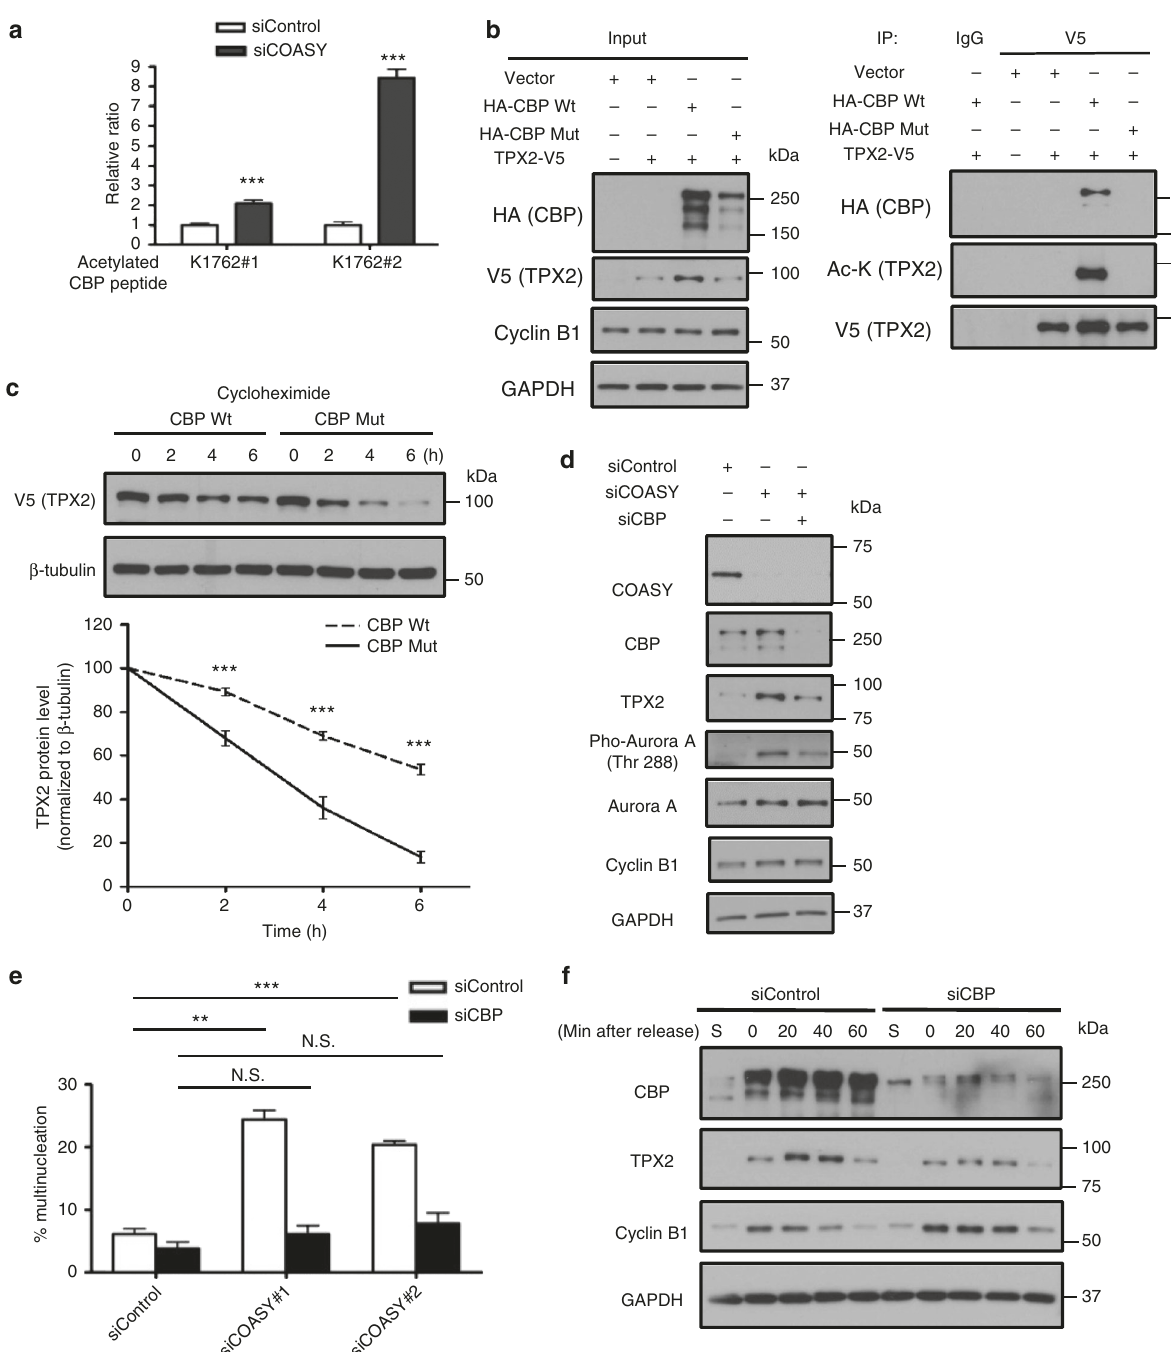
Fig. 4 CBP acetylates and stabilizes TPX2 protein level. a COASY knockdown increased two CBP-acetylated peptides that cover K1762. b CBP-acetylated TPX2 in vivo. Wild type or catalytic-de fi cient mutant of HA-tagged CBP was cotransfected with V5-tagged TPX2 into HEK-293T cells. After 20 min of release from thymidine-nocodazole block, the V5-tagged TPX2 was then immunoprecipitated with control (IgG) or V5 antibody (V5) and then probed with HA (CBP), acetylated lysine or V5 (TPX2). Wild type, but not catalytic-de fi cient mutant, CBP increased TPX2 acetylation and levels. c CBP increased the half-life of TPX2. Wild type or catalytic-de fi cient mutant of CBP was cotransfected with V5-tagged TPX2 into unsynchronized HEK-293T cells. After 24 h, the protein synthesis of the transfected cells was halted with 25 mg/ml cycloheximide and collected at the indicated times for western blots. The TPX2 protein level at indicated time points was quanti fi ed by Image J software and normalized to b-tubulin protein level. d CBP siRNA abolished the increased TPX2 and Aurora-A phosphorylation caused by COASY knockdown. A549 cells transfected with control, siCOASY or siCBP were released from thymidine- nocodazole block for 20 min and probed for western blots using indicated antibodies. The phosphorylated Thr 288 of Aurora A indicates activation. e CBP knockdown rescued the multinucleation caused by COASY knockdown. Multinucleation was determined by immuno fl uorescence. f CBP knockdown decreased TPX2 protein level during mitosis. A549 cells transfected with siRNA targeting CBP were synchronized by thymidine-nocodazole block and released in fresh media. The released cells were harvested every 20 min and probed with indicated antibodies. To examine TPX2 protein level in S phase, additional samples were harvested after 24 h of thymidine block. Bars show standard error of the mean. a , e N.S. not signi fi cant *** p < 0.001, ** p < 0.01, two-tailed Student ’ s t -test, n = 3 independent repeats. c Two-way ANOVA: p < 0.0001. Bonferroni post hoc tests, *** p < 0.001, n = 4 independent